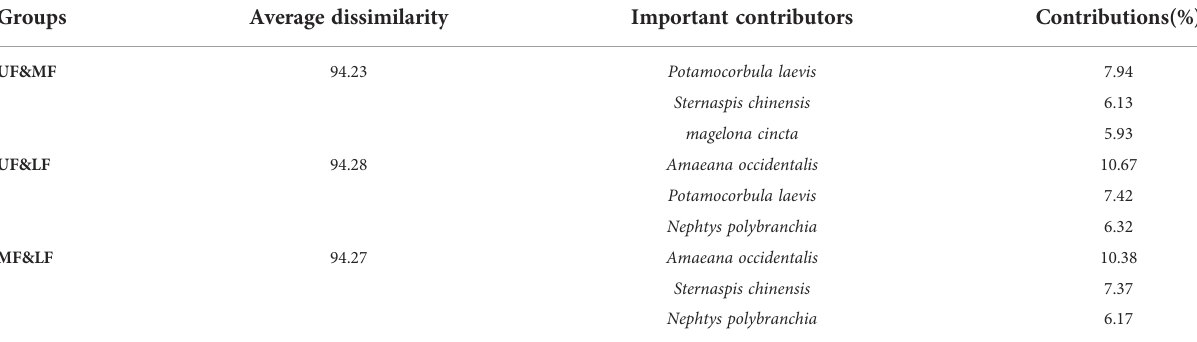
TABLE 3 Average dissimilarity in community structure, and the three most important contributors in and adjacent to the secondary front, Hangzhou Bay.